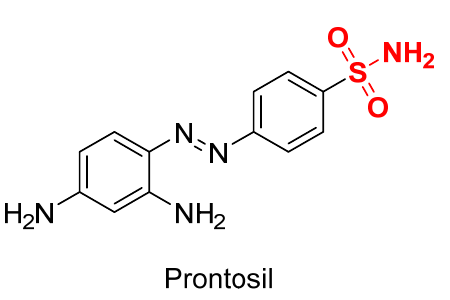
Figure 3. Chemical structure of prontosil. The sulfonamide moiety is shown in red.